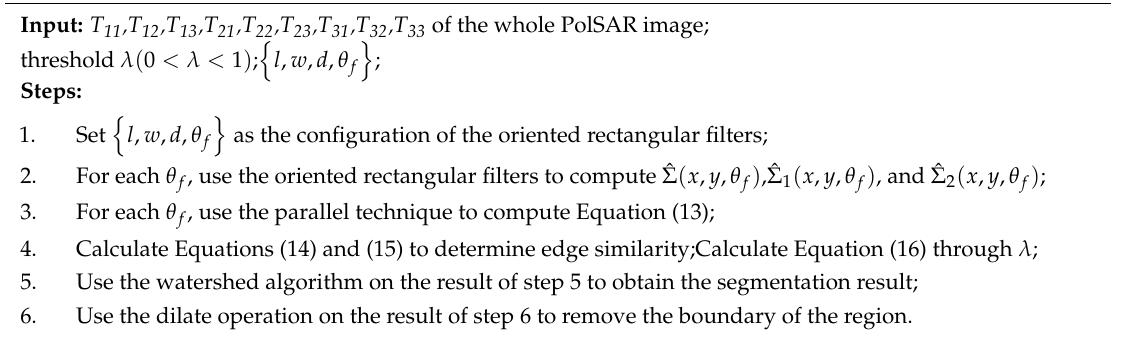
Algorithm 1: Algorithmic steps of Fast Super-Pixel Generation